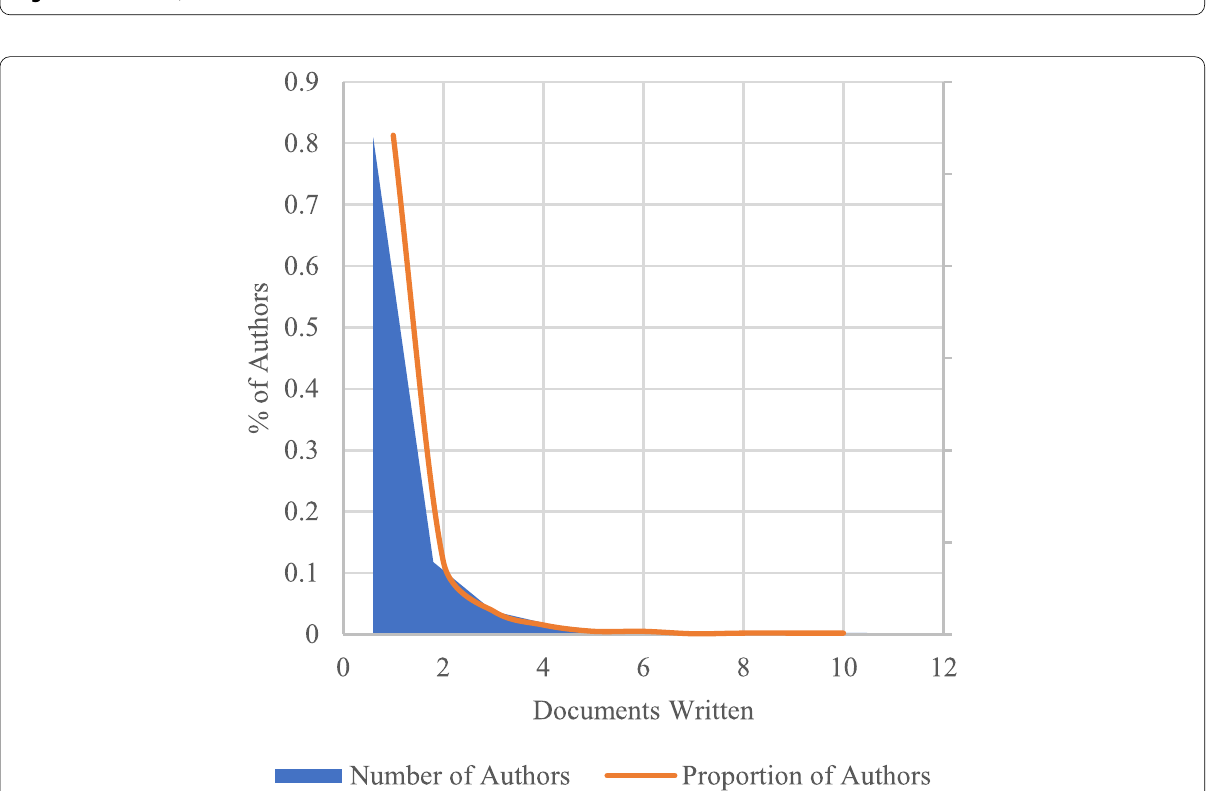
Fig. 15 Membranes, Lotkas Law